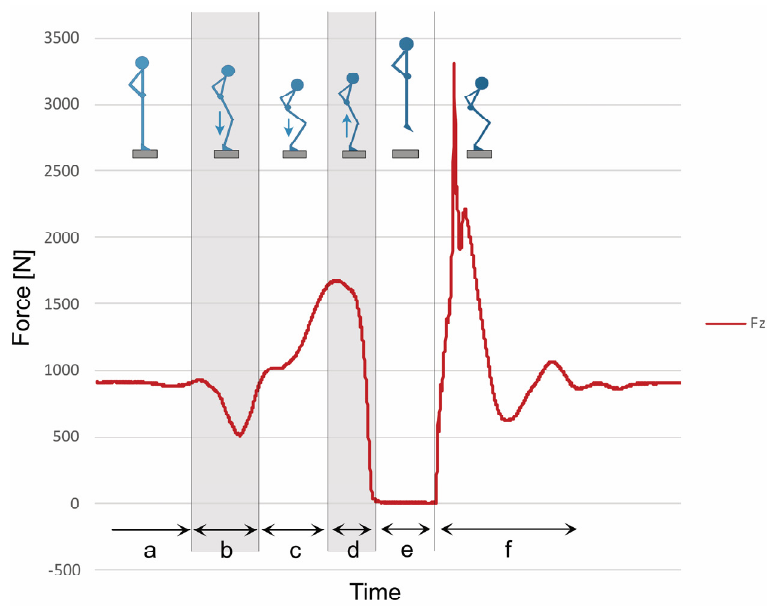
Figure 1. Countermovement jump phases in ground reaction curve. a = weight phase, b = unweight phase, c = eccentric phase, d = concentric phase, e = flight phase, f = landing phase; Fz = resultant force.